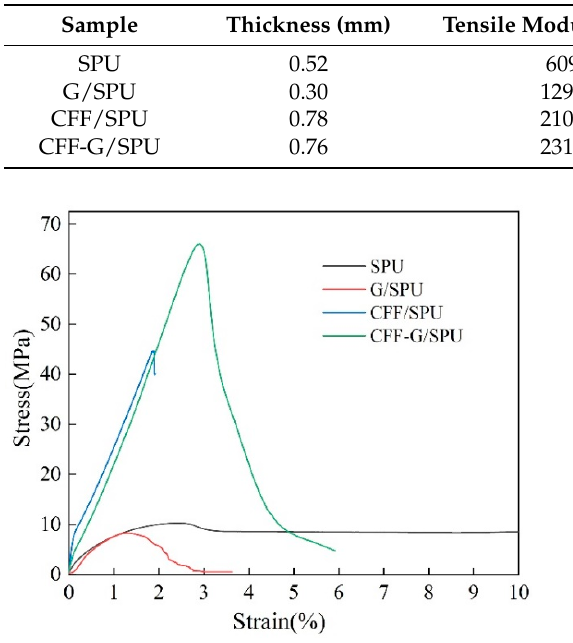
Table 1. Mechanical properties of SPU, G/SPU, CFF/SPU and CFF-G/SPU.